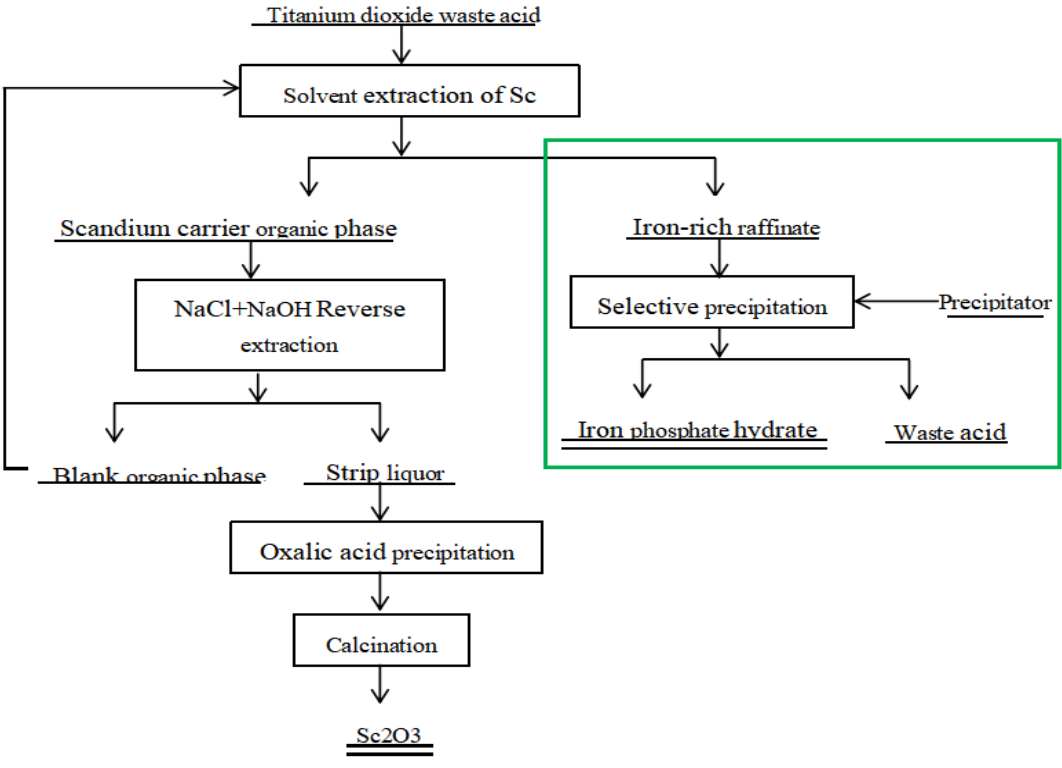
Figure 2. Technological route for the step extraction of valuable components from titanium dioxide waste acid.